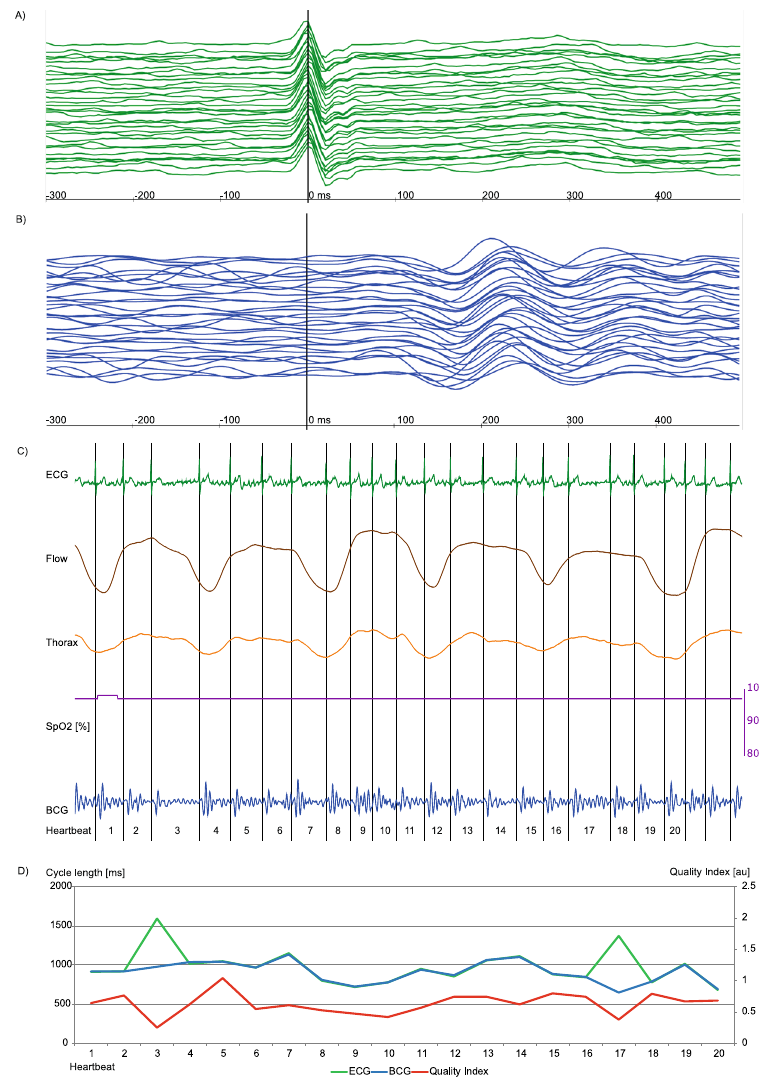
Figure 4. Episode of AF with good signal correlation, for heartbeat 3 and 17 the BCG algorithm estimated a wrong cycle length due to a hampered signal indicated by a low QI (red line, Fig. 4d). Each signal is visualized by a unique colour: ECG (green), BCG (blue), Airflow (brown), thorax movement (orange), oxygen saturation (purple) and QI (red). ( A , B ) Plot of 23 consecutive heartbeats. The upper-most signal is the start, the bottom- most is the end of the sequence. The signals are synchronized and the maximum of R peak in ECG signal is situated at 0 ms. A: In the ECG signal, atrial fibrillation is shown. ( B ) Slightly differing height and chronological appearance of ventricular mechanical contraction in amplitude sequence can be seen. ( C ) The recorded signal during polysomnography is plotted. Flow and thoracic movement show normal movement and oxygen saturation is always in the upper 90%. A continuous measurement in BCG is possible, but the signal in the ECG indicates an absolute arrhythmia due to atrial fibrillation. ( D ) The diagram shows heartbeat cycle length of ECG and corresponding estimated BCG cycle length, as well as the calculated QI are shown. For the most time –during AF – ECG and estimated cycle length of the BCG signal correlate well with a near perfect overlap of the ECG (green) and BCG (blue) line. For heartbeat 3 and 17 the estimated cycle length by the BCG algorithm differs strongly from the ECG. For these cases, the QI decreases, indicated by a dip of the red line at these heartbeats. However, due to the flexible algorithm the following heartbeats are calculated